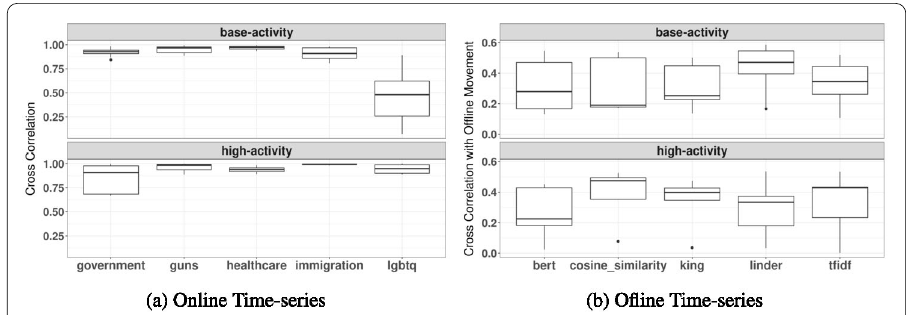
Figure 6 Time-series cross-correlation Results